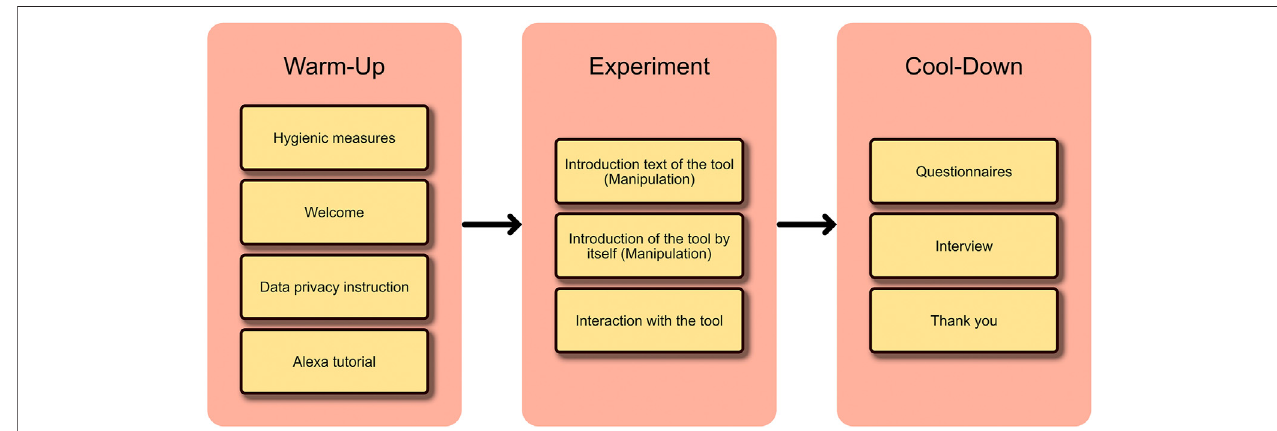
FIGURE 1 | Illustrates the procedure of